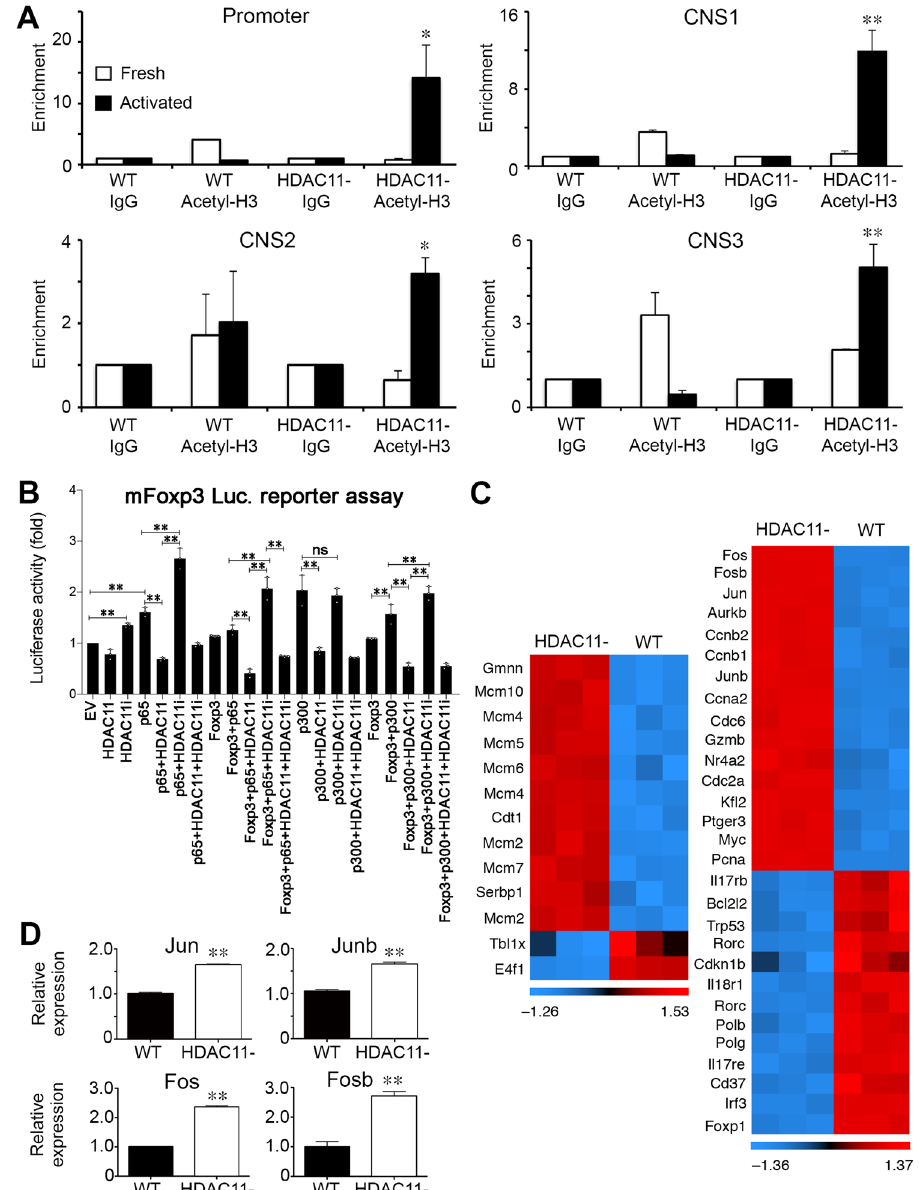
Figure 3. Conditional HDAC11 deletion promotes chromatin remodeling at the Foxp3 locus and Treg gene expression. ( A ) ChIP studies of the Foxp3 promoter and 3 enhancer regions in WT vs. conditional HDAC11 − / − Treg cells, showing increased acetyl-H3 binding at all 4 sites in HDAC11 − / − vs. WT Treg cells. ( B ) Luciferase reporter assays showing the impact of overexpression, and also inhibition, of HDAC11 in 293 T cells that were transiently transfected with murine Foxp3-promoter-Luc vector plus expression vectors for p65, HDAC11, Foxp3, and p300, as specified, or empty vector (EV) along with 50 ng of pRL-TK Renilla luciferase internal control vector; EV was added to ensure equal amounts of DNA per reaction. After 48 h, cells were treated with PMA (6 ng/ml) and ionomycin (1 μ M) for 5 to 6 h, and 1 μ M HDAC11i where specified, and cell lysates were harvested for luciferase assays. Firefly luminescence data was normalized to Renilla luminescence and analyzed by ANOVA ( * p < 0.05, ** p < 0.005); data are representative of the results of 3 or more independent experiments. ( C ) Heat-map of selected genes that were upregulated (red) or downregulated (blue) in conditional HDAC11 − / − vs. WT Treg cells. ( D ) qPCR evaluation of WT vs. conditional HDAC11 − / − Treg cells, showing increased expression of Jun, Junb, Fos and Fosb in HDAC11 − / − Tregs; normalized data are shown as mean ± SD, 4 mice/group, and * p < 0.05, ** p <